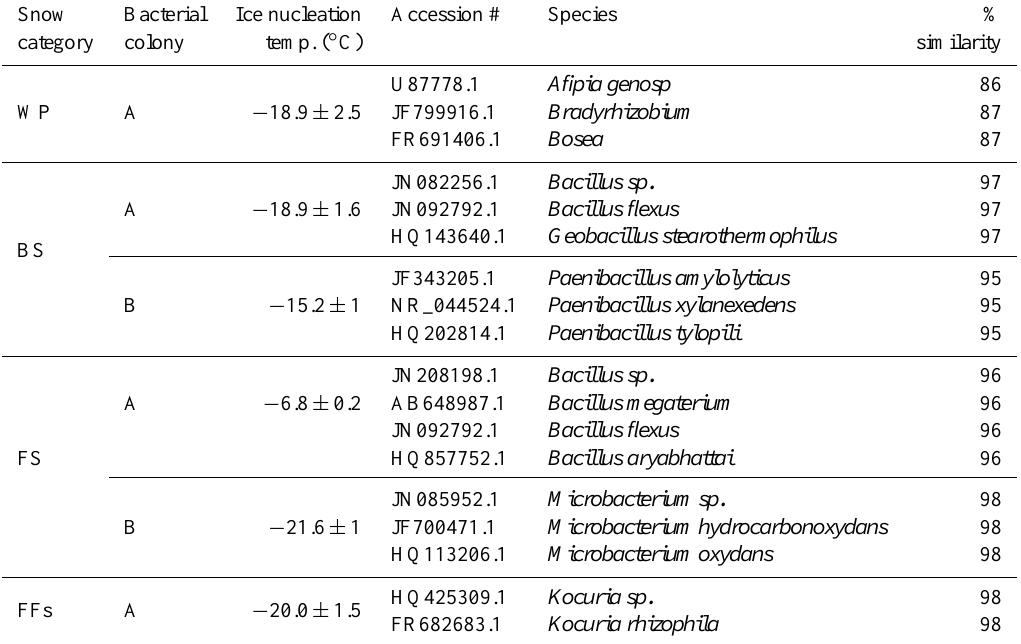
Table 3. Ice nucleation of identified viable cultivable bacteria in Arctic sample. Ice nucleation temperature of identified bacterial isolates in each snow categories: blowing snow (BS), fresh snow (FS), windpack (WP), and frost flowers (FFs); accession number, a unique identifier given to a DNA sequence; identified species; and % similarity, the ratio of identical query bases to known bases in the